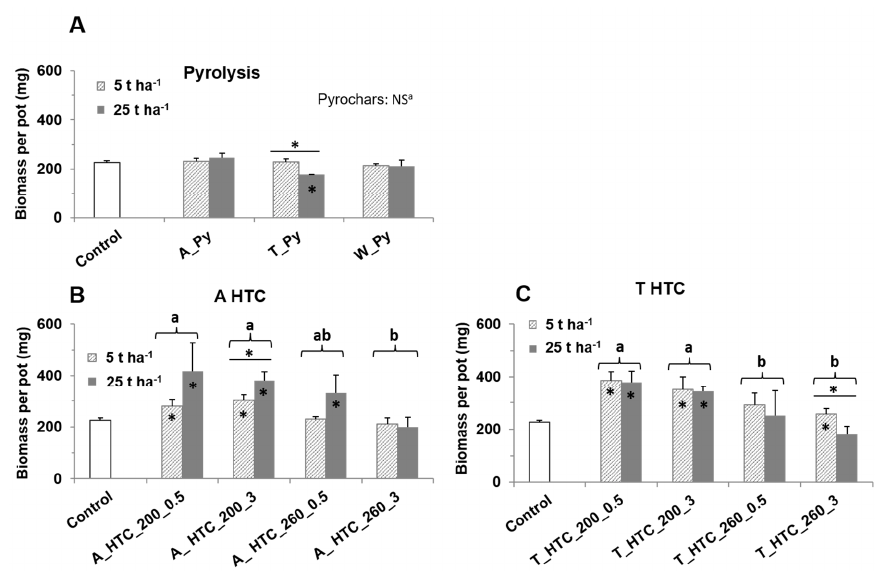
Figure 3. Biomass production per pot (mg) of Lolium perenne in: ( A ) Control and pyrochars-amended pots, ( B ) Control and pots amended with hydrochars derived from A_SS and ( C ) Control and pots amended with hydrochars derived from T_SS. Hydrochars were produced from primary (A_) and secondary (T_) sewage sludges at 200 °C (_HTC_200) and 260 °C (_HTC_260) for 0.5 and 3 h (_0.5, _3, respectively). Pyrochars were produced from primary (A_) and secondary (T_) sewage sludges (_Py). NS: no significance. Asterisks inside the bars show significant di ff erences to the control according to the t -test. The above-line asterisks indicate significant di ff erences among doses according to the t -test. The letters show significant di ff erences among treatments according to Tukey’s test. Agronomy 2019 , 9 , x FOR PEER REVIEW